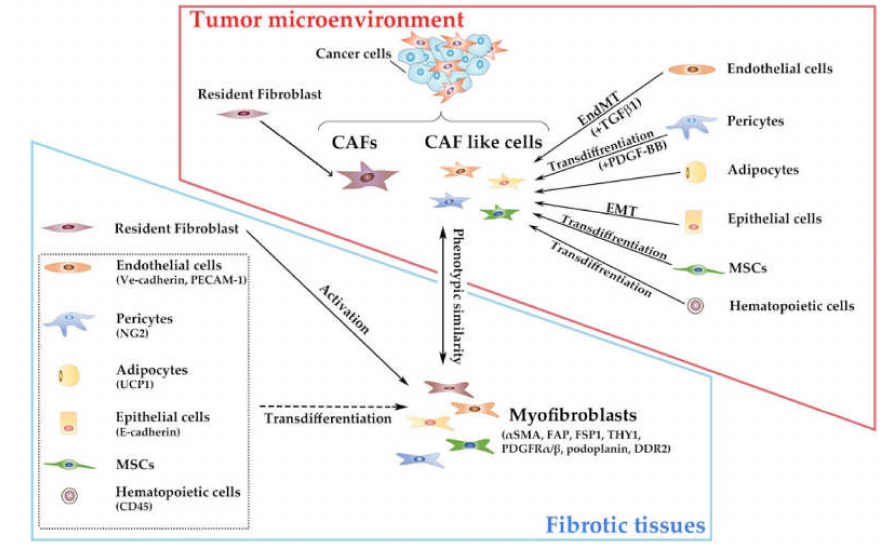
Figure 1. Ontogeny and phenotypes of cancer-associated fibroblasts (CAFs) and myofibroblasts. Parentheses indicate representative surface makers of each cell population. Used abbreviations: PECAM-1, platelet endothelial cell adhesion molecule-1; UCP1, uncoupling protein